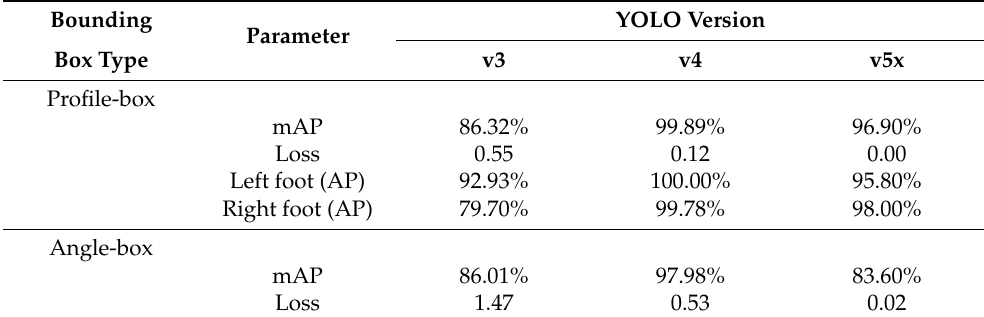
Table 1. YOLOv3, v4, and v5x performance in bounding box training on the foot profile (profile-box) and FPA (angle-box).